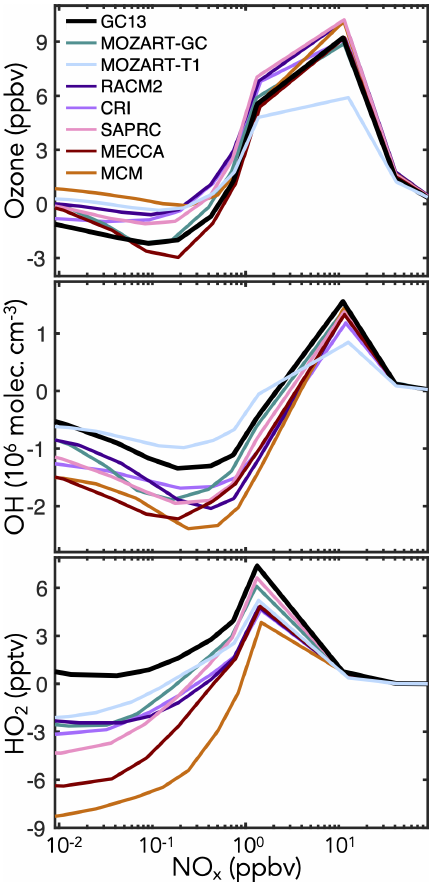
Figure 8. Changes in midday ozone, OH, and HO 2 concentrations due to aromatic chemistry in box model simulations of the con- tinental boundary layer with different aromatic oxidation mecha- nisms. Changes in species concentrations are calculated by sub- tracting their midday (10:00–14:00LT) mean values in a simula- tion without aromatic emissions from those in an equivalent simu- lation with aromatic emissions, and these values are plotted against the midday NO x mixing ratio. Aromatic emissions are 120ppth − 1 with 2 : 2 : 1 molar ratios for benzene:toluene:xylenes. Additional model setup is described in Sect. 4.1.